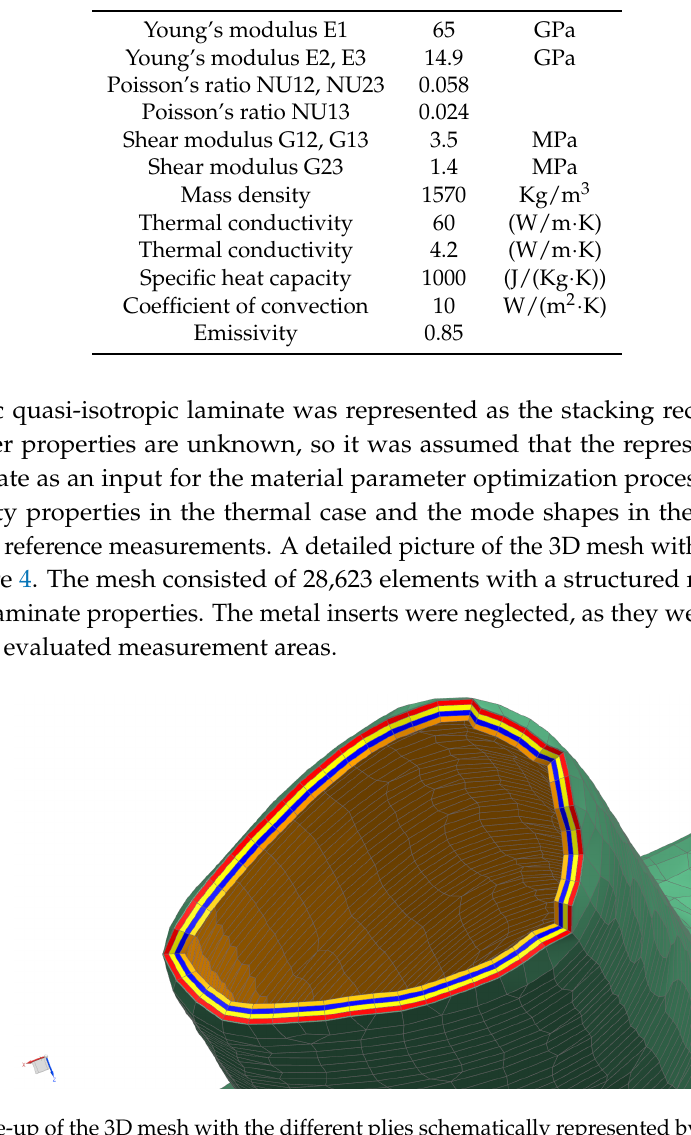
Figure 4. Close-up of the 3D mesh with the different plies schematically represented by different